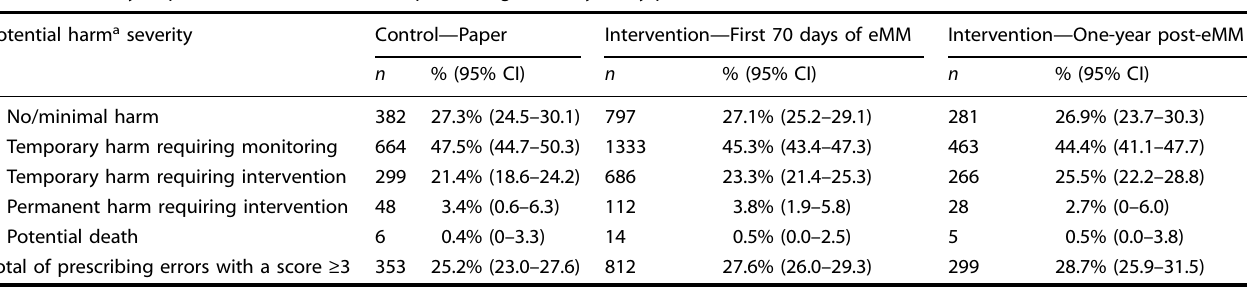
Table 5. Severity of potential harm from clinical prescribing errors by study